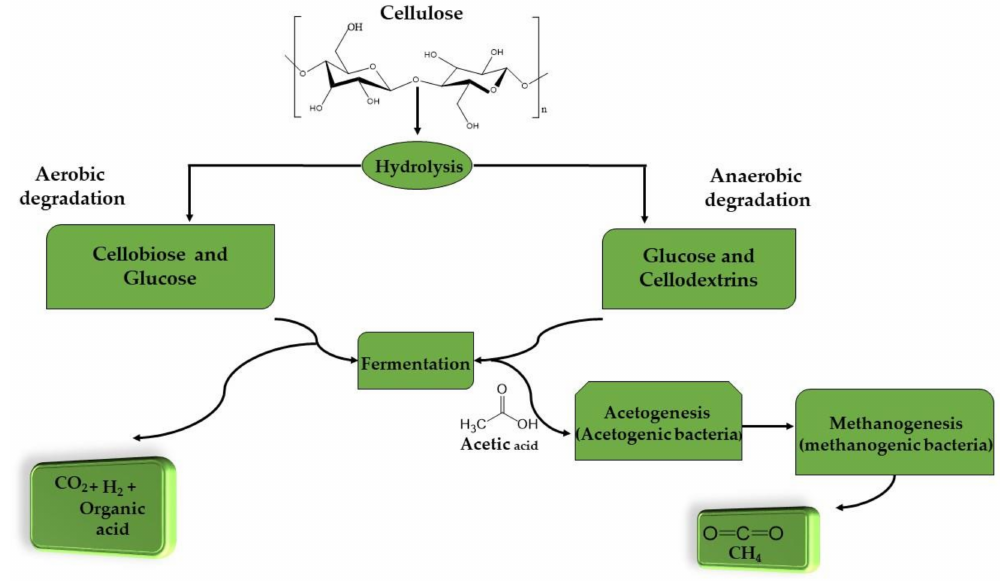
Figure 2. Aerobic and anaerobic degradation of cellulose showing the primary and secondary